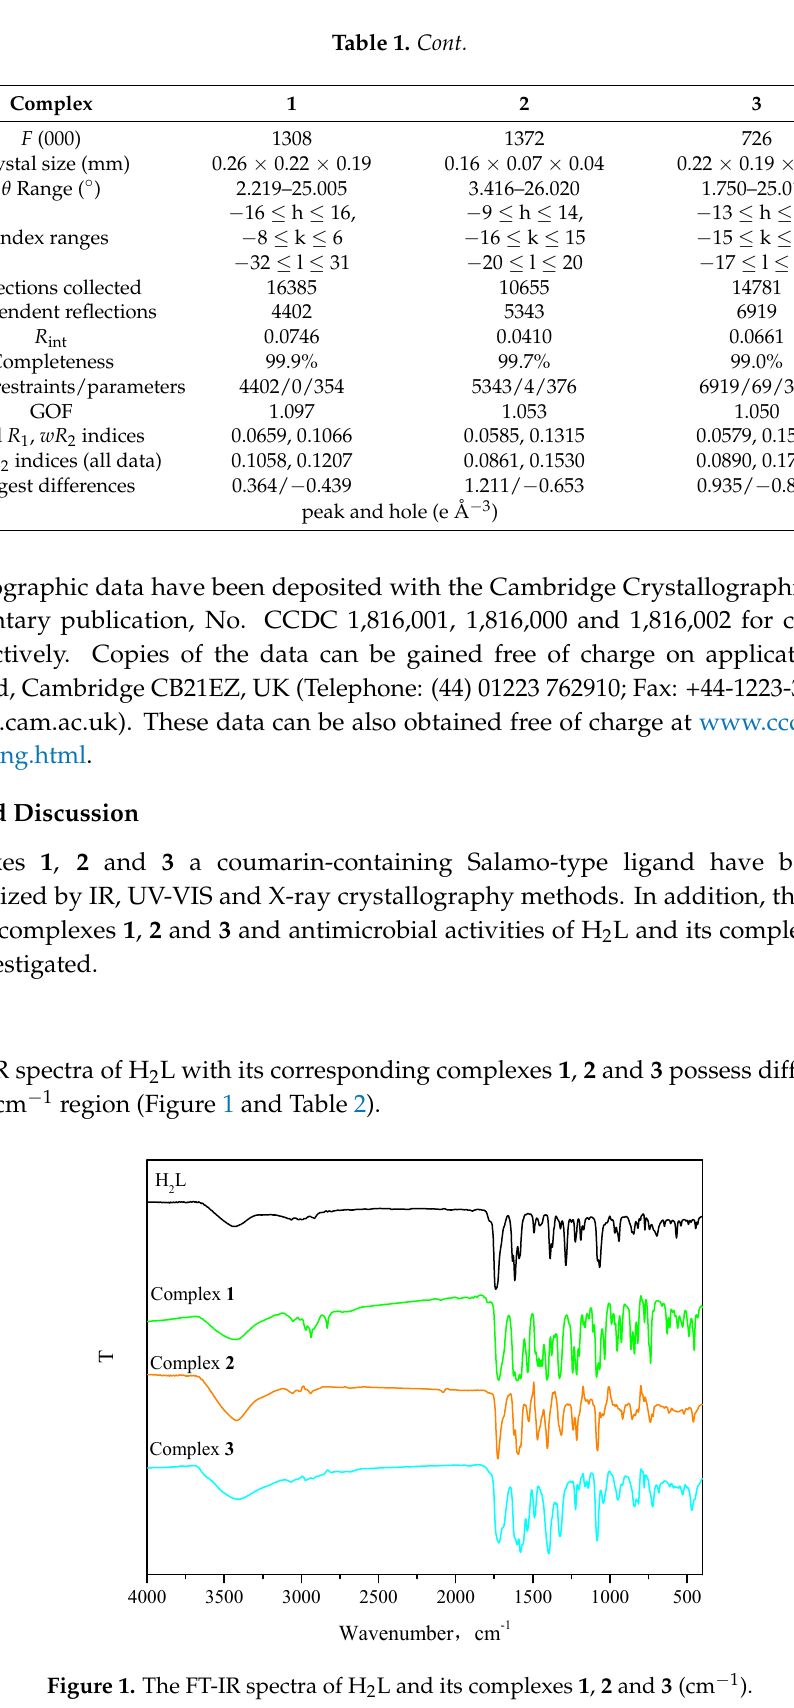
Figure 1. The FT-IR spectra of H 2 L and its complexes 1 , 2 and 3 (cm − 1 ).